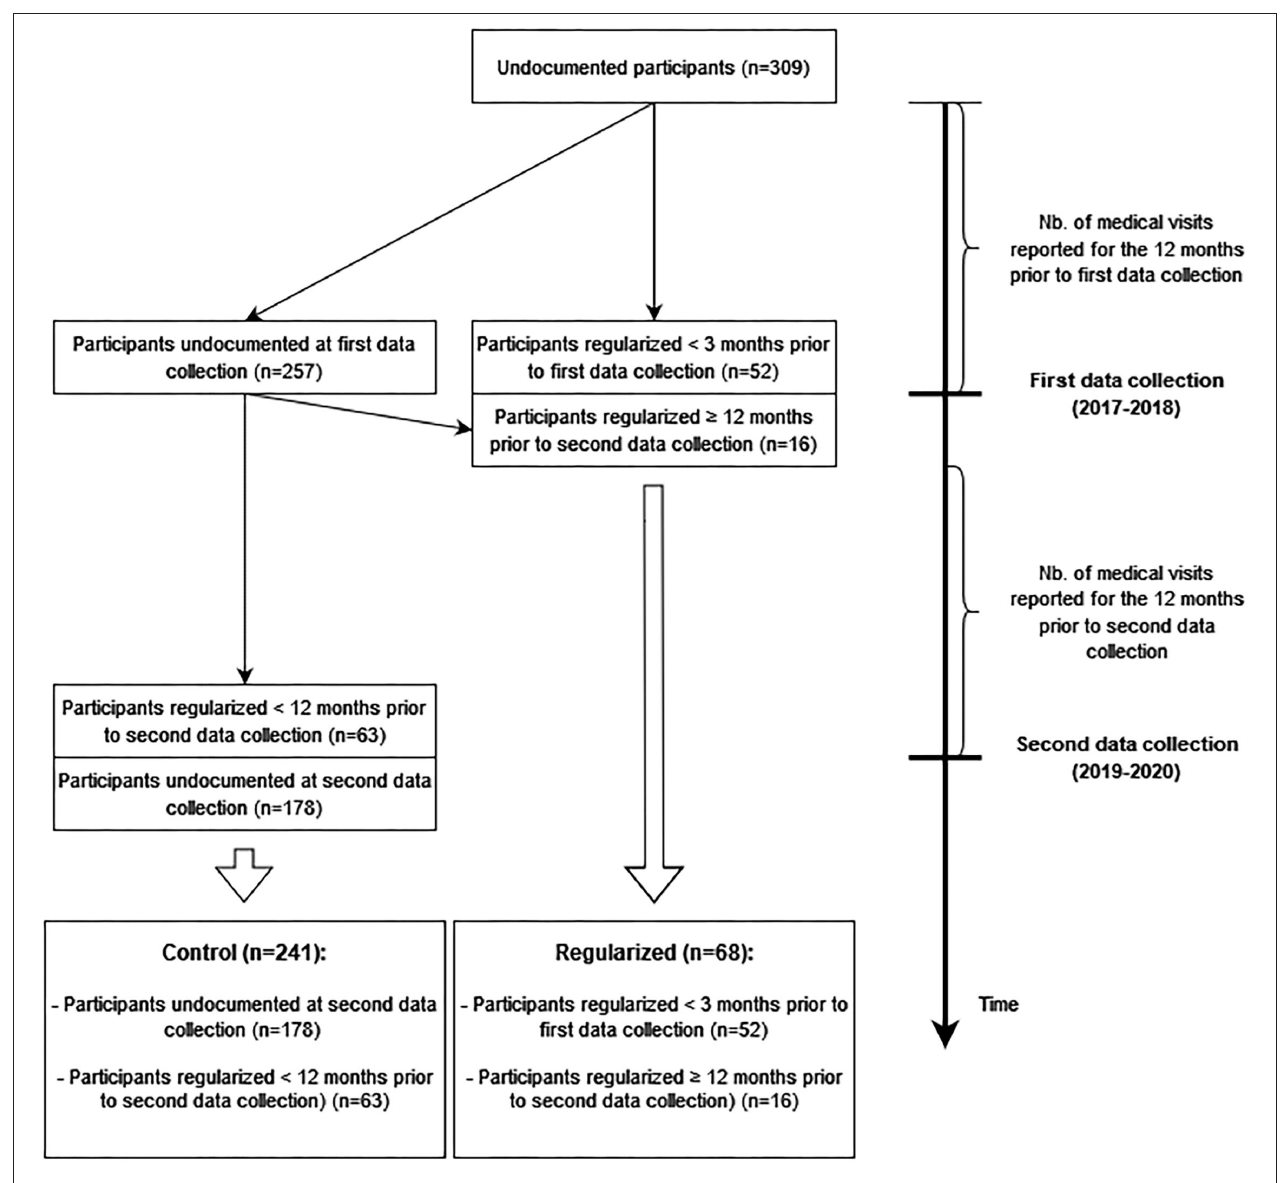
FIGURE 1 | Assignment of participants to residence status groups over